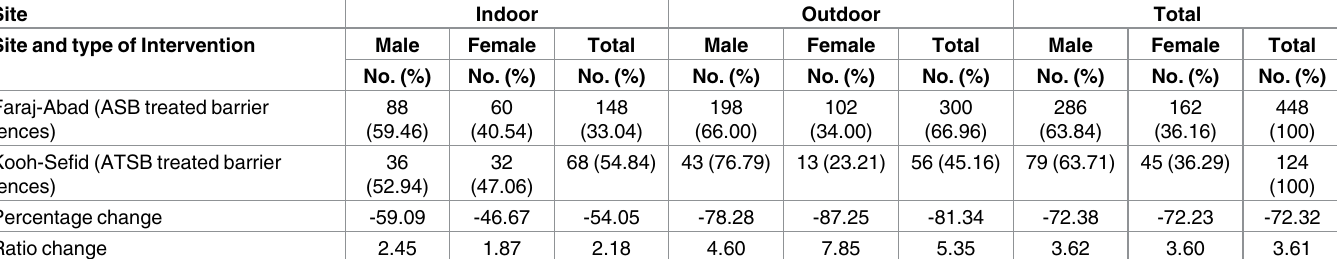
Table 7. The comparison of P . papatasi frequency indoors and outdoors of Kooh-Sefid and Faraj-Abad using light traps (ATSB and ASB treated barrier fences), Markazi district, Qom province, 2015. Site Indoor